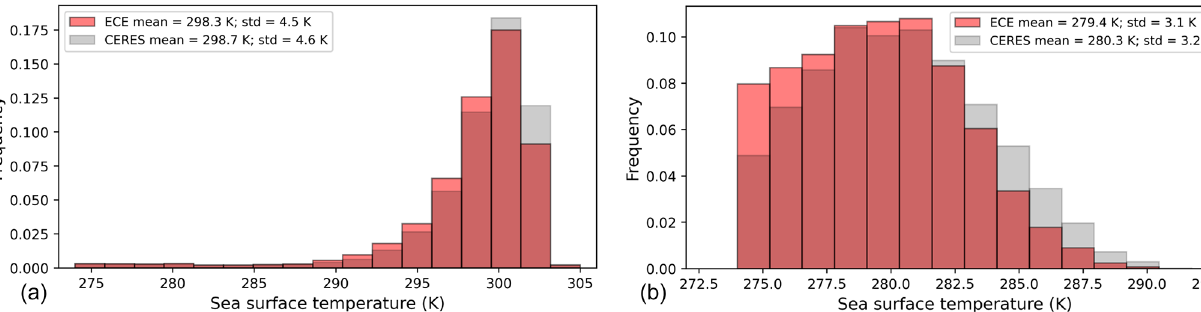
Figure 7. Distribution of sea surface temperature of the model for cloud fraction < 30%, assuming the EC-Earth (red) or the CERES (grey) cloud fractions. The distributions were computed for tropical latitudes ( − 30 ◦ S, + 30 ◦ N) (a) and mid-latitudes ( − 60 ◦ S, − 45 ◦ S) (b) .